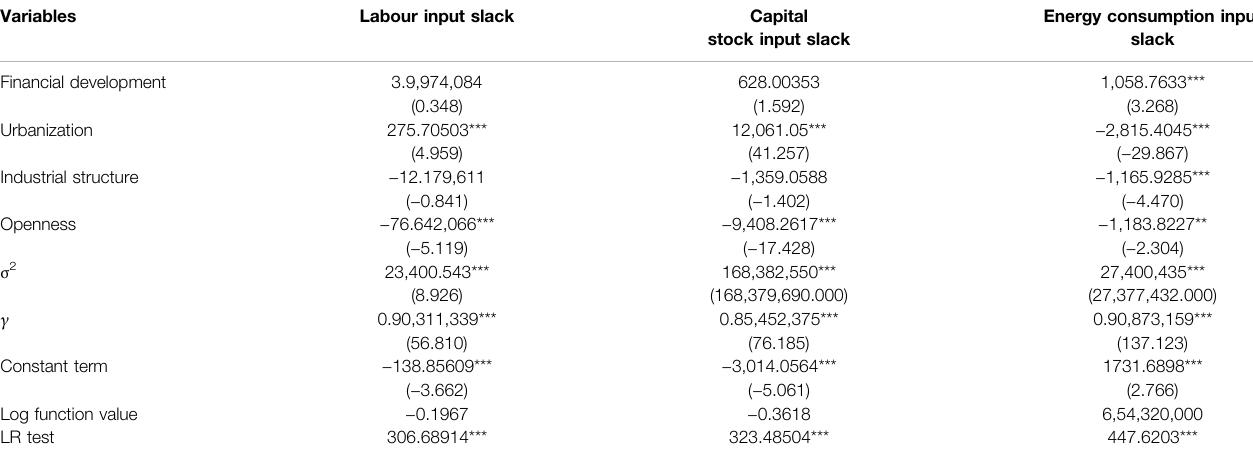
TABLE 2 | Regression results of the second-stage (SFA).